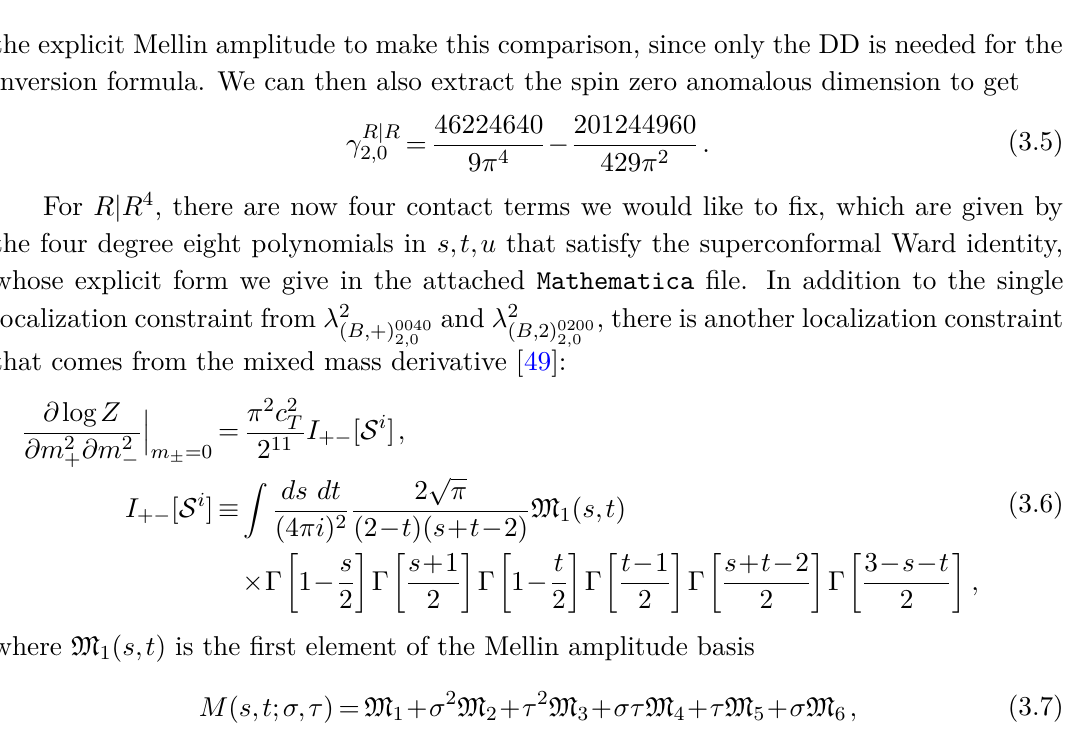
Table 2 . Comparison of nontrivial pairs of OPE coefficients λ pp M λ qq M of multiplets M that appear in the h ppqq i correlators for p,q = 2 , 3 between the exact values computed for the interacting N = 3 ABJM theory in [31], and the all order in 1 /N expressions given here. We show enough digits for each quantity to show the first digit of